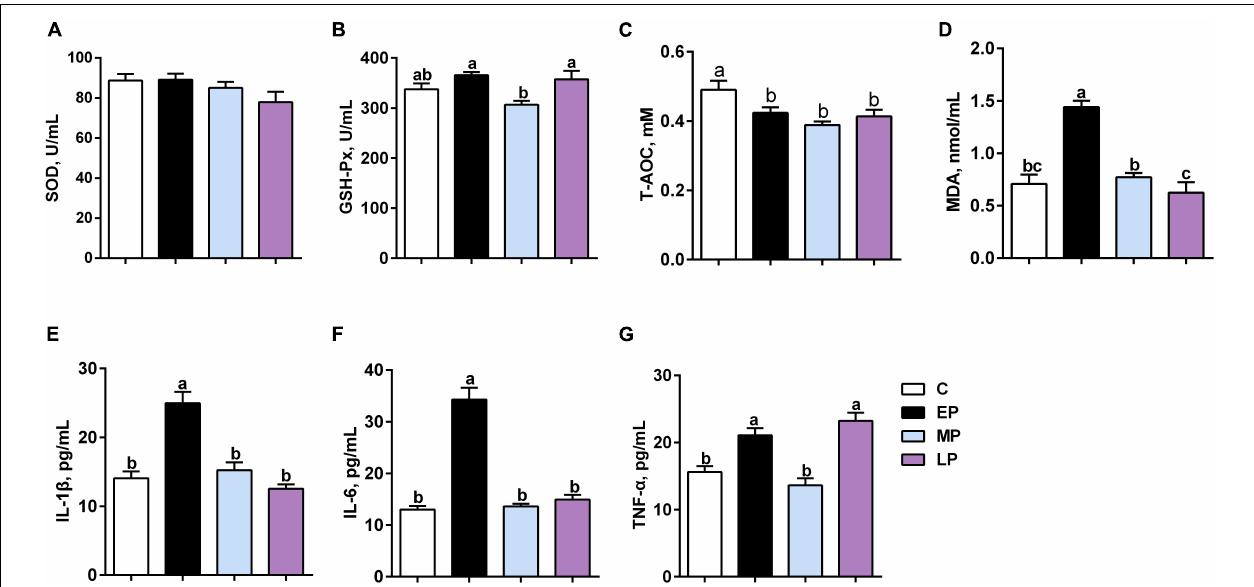
FIGURE 1 | Serum oxidative status and inflammation in Dezhou donkeys during different gestation stages. (A) SOD (superoxide dismutase); (B) GSH-P X (glutathione peroxidase); (C) T-AOC (total antioxidant capacity); (D) MDA (malondialdehyde); (E) IL-1 β (interleukin-1 beta); (F) IL6 (interleukin 6); and (G) TNF- α (tumor necrosis factor alpha). C, non-pregnancy as a control; EP, early-stage pregnancy; MP, middle-stage pregnancy; LP, late-stage pregnancy. Data indicate means ± SEM ( n = 6). a , b , c Means with different letters are significantly different, p <